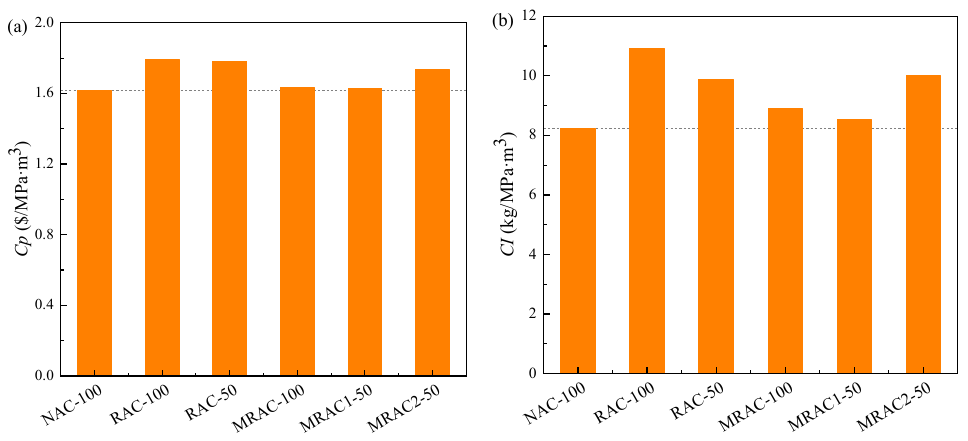
Figure 10. The cost and environmental impact assessment of the concrete. ( a ) C p , ( b ) CI .